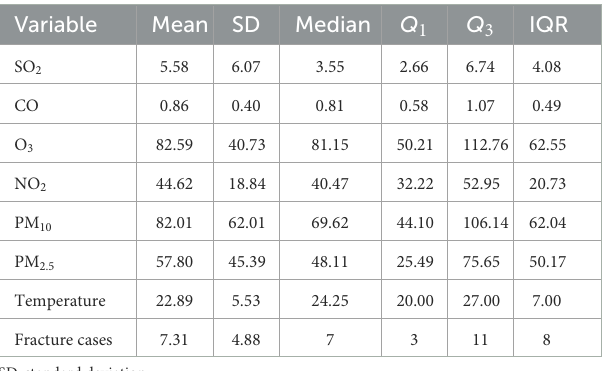
TABLE 1 Baseline characteristics of the study population.